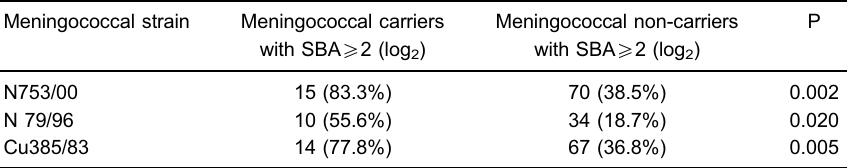
Table 3. Frequency of carriers (n=18) and non-carriers (n=182) with protective levels of serum bactericidal antibodies (SBA) against meningococcal strains. Meningococcal